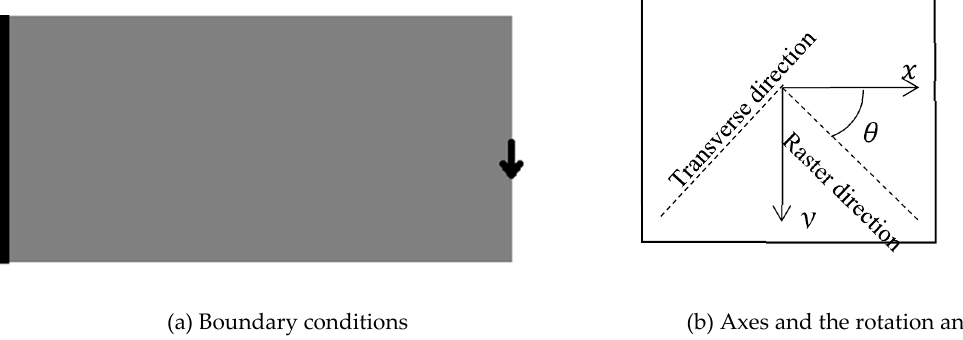
Figure 5. Schematic of the cantilever problem definition.